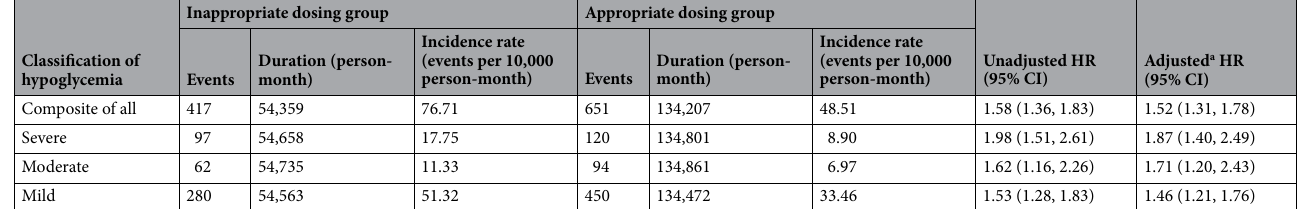
Table 2. Risk of hypoglycemia associated with inappropriate and appropriate dosing. a Adjusted for patient age, sex, number of previous severe hypoglycemic events within the previous year, number of concurrent use of glucose-lowering drugs, use of insulin, use of sulfonylurea, Charlson Comorbidity Index, and HbA 1C .